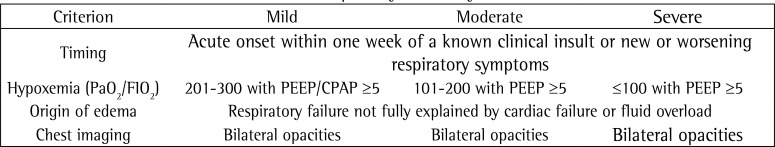
Berlin classification of acute respiratory distress syndrome(173) PaO2/FIO2
- relationship between oxygen partial pressure and fraction of inspired oxygen;
PEEP - positive end-expiratory pressure; CPAP - continuous positive airway
pressure.